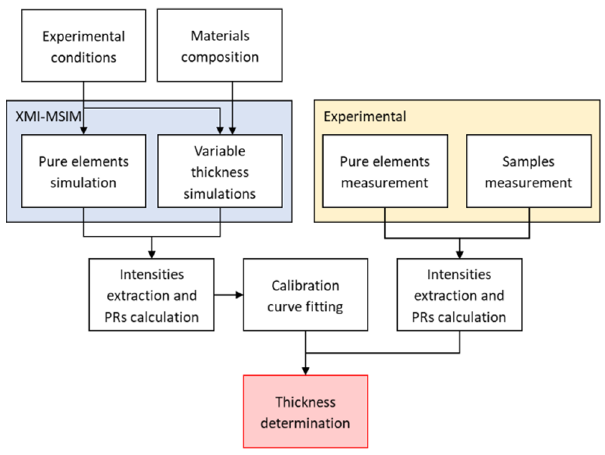
Figure 1. Flowchart of the algorithm used for the quantification process.